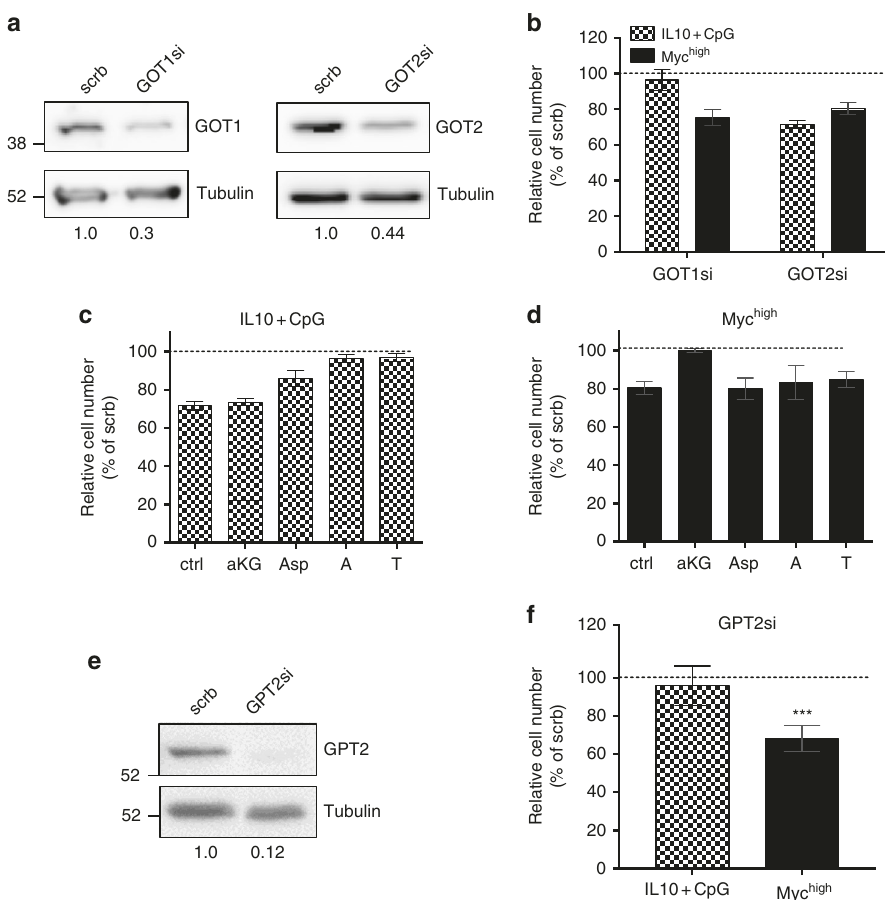
Fig. 4 GOT2 supports the proliferation of IL10 + CpG-stimulated and MYC-overexpressing cells. a Transient knockdown of GOT1 and GOT2 in P493-6 cells was performed by siRNA transfection. Knockdown ef fi ciencies (GOT*/tubulin) relative to scrb control are provided under the images. b Relative cell numbers of IL10 + CpG-stimulated P493-6 MYC low and P493-6 MYC high after GOT1 or GOT2 knockdown depicted in a . Relative cell numbers of c IL10 + Fig. 2. e Transient knockdown of GPT2 in P493-6 cells performed by siRNA transfection. Knockdown ef fi ciencies (GPT2/tubulin) relative to scrb control are provided under the images. f Relative cell numbers of IL10 + CpG-stimulated P493-6 MYC low and P493-6 MYC high cells after GPT2 knockdown as depicted in e . All experiments were performed in triplicates. For b – d and f , error bars represent mean ± SD of three independent experiments and results from Bonferroni post hoc tests on a one-way ANOVA are given (* p < 0.05, ** p < 0.01, *** p <